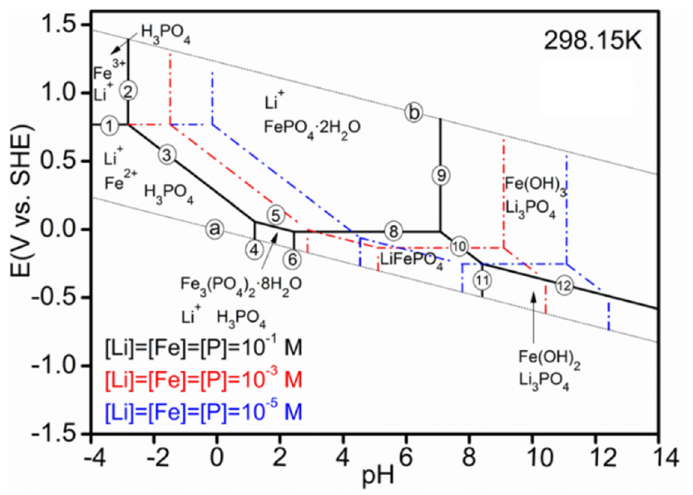
Figure 5. Pourbaix Diagram for the Li–Fe–P–H2O system at 25 °C [108].